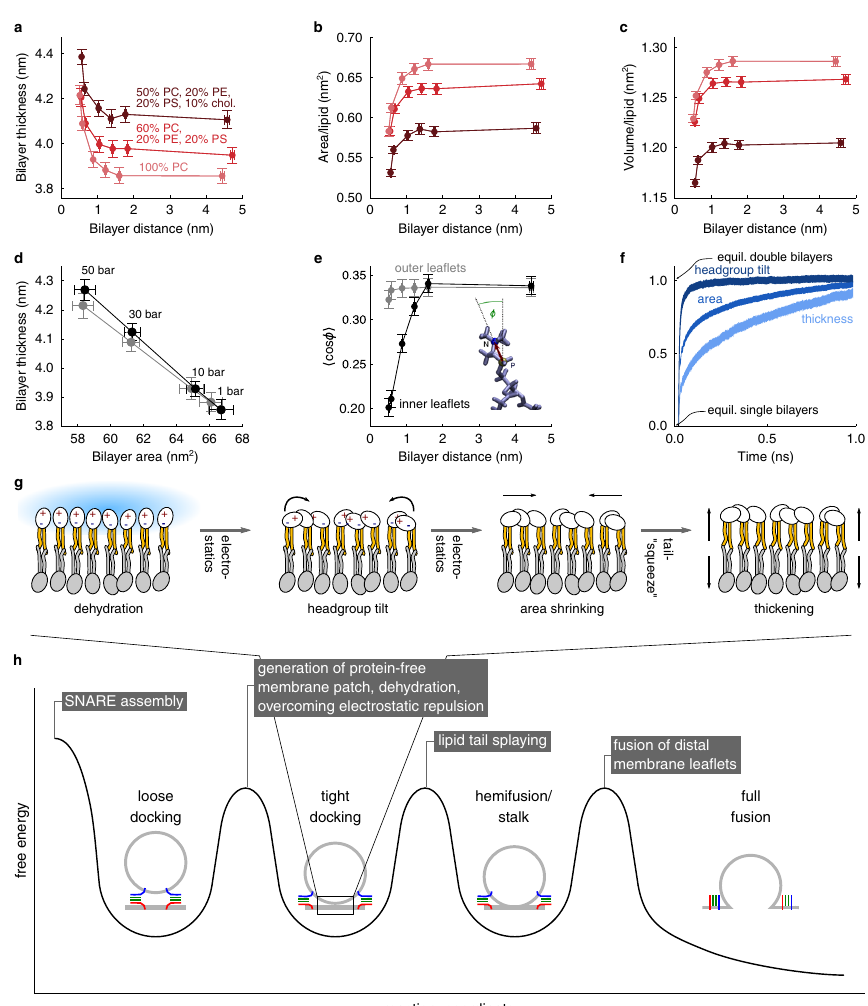
Fig. 4 Membrane thickening at close distances is caused by dehydration-driven electrostatically-induced headgroup tilt and area compression. Atomistic molecular dynamics simulations show changes in membrane thicknesses ( a ), area ( b ), and volume ( c ) when two membranes with three different lipid compositions are apposed to each other at various distances. d Enforced membrane area compression reproduces membrane thickening at close distances. e Lipid headgroups within the inner membrane lea fl et at the docking interface exhibit higher tilt (cos ϕ ) upon close approach. Data points ( a – e ) are averages from 19000 points (190ns) ± SD as described in Methods . f Change of headgroup tilt, area, and thickness over time during equilibration to a double-membrane stack (average over all 500 simulation runs; for easier comparison, all values were normalized to a range between 0 and 1). Accordingly, a value of 0 corresponds to equilibrated single bilayers and a value of 1 corresponds to equilibrated double bilayers. Data ± SD. g Scheme proposing order of events resulting in membrane thickening. h Cartoon showing a simpli fi ed energy landscape for membrane fusion. The energy barriers and minima are de fi ned by observations of arrested intermediate states, their magnitude being arbitrary. Scaling on the y -axis is arbitrary. Source data are provided as a Source Data fi secretory cells such as neurons fusion may be arrested at this state. It nm apart from each other. This is followed by an energy barrier is conceivable that the energy barrier separating this state from stalk (Fig. 4h): Water and ions must be removed from the membrane formation and subsequent fusion is moderate (since energy barrier contact zone, and the electrostatic repulsion between opposite lipid due to water and ions between membranes is not present any more) headgroups needs to be overcome 1,2 , possibly further assisted by and can easily be overcome by accessory proteins perturbing lipid membrane stretching generated by SNARE complexes. We now demonstrate that a metastable state follows that is characterized by a partially dehydrated and tight adhesion between membranes. The contact zone is free of proteins, does not require, albeit being stabi- lized by, divalent cations, and is associated with dehydration and a change in lipid organization, resulting in membrane thickening. Progression towards stalk formation probably requires tail splaying of membrane lipids 3 which may be facilitated by the increased hydro- phobicity and the changed lipid head geometry at the contact site. Probably, stalks are initiated at the edge of the membrane contact zone where increased curvature may cause lipid packing defects facilitating such transitions and assisted by assembly of SNARE complexes located at the rim 8 . Furthermore, we propose that in fast